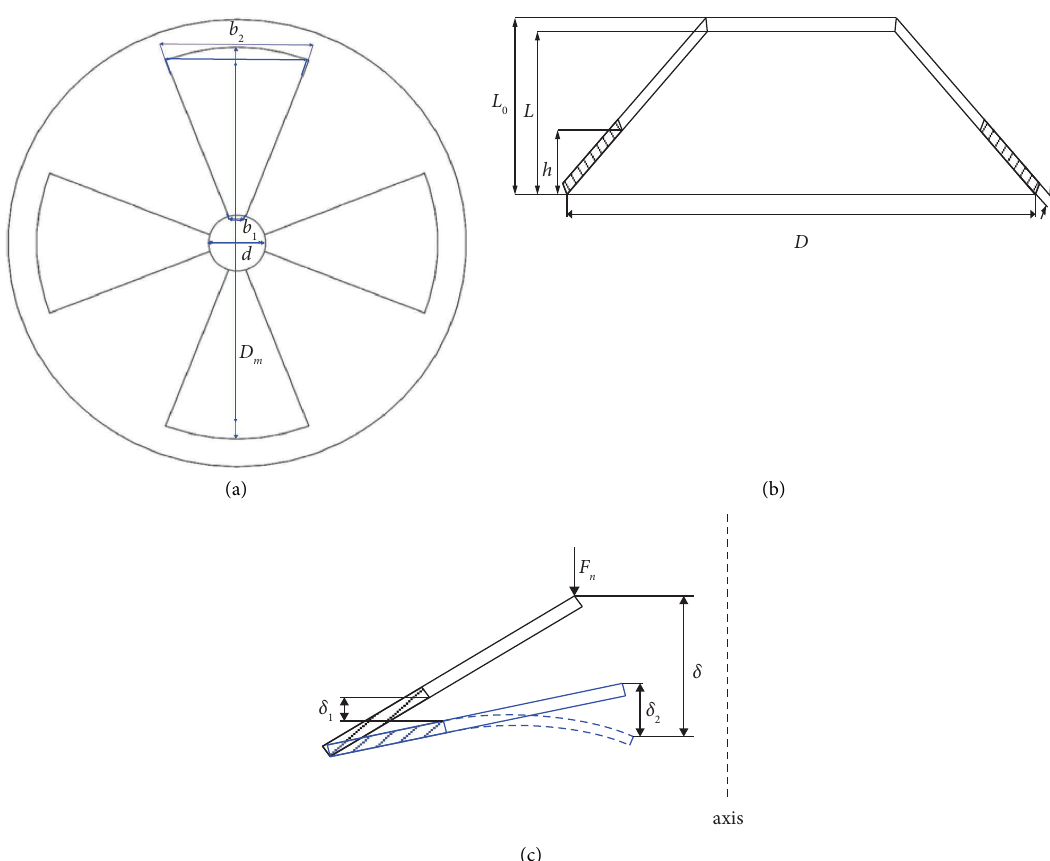
Figure 5: Mechanical model of BQZSS: (a) vertical view, (b) front view, and (c) deformation of